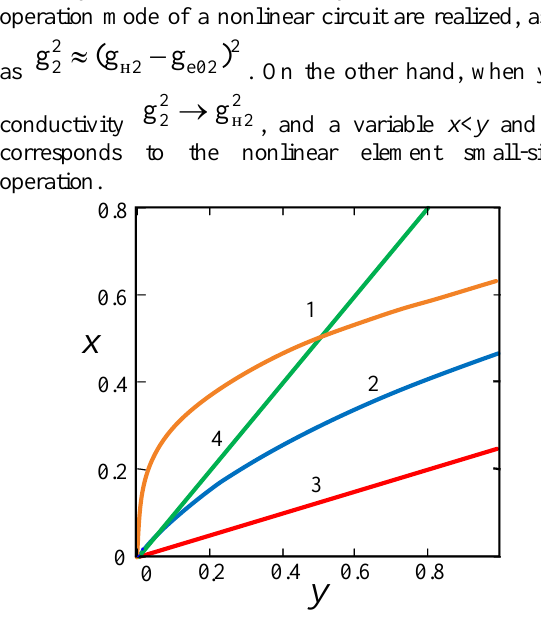
Figure 2. Disturbance intensity variation in uniform electromagnetic field of equivalent